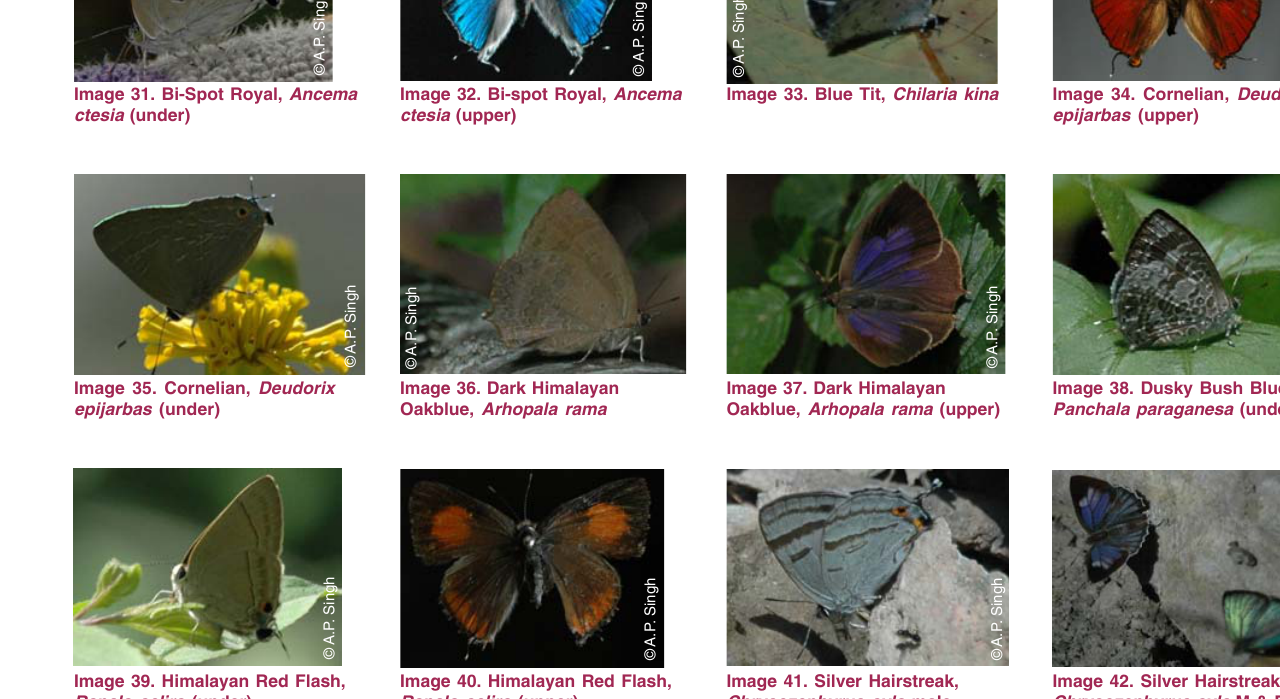
Image 39. Himalayan Red Flash, Rapala selira (under)